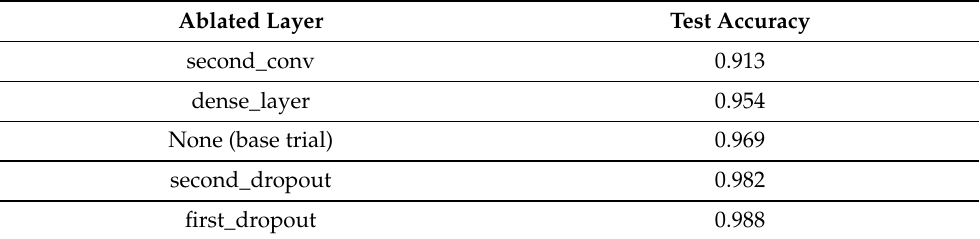
Table 4. A ranking of the average accuracies of the test set in ascending order resulting from excluding layers of interest from the base model